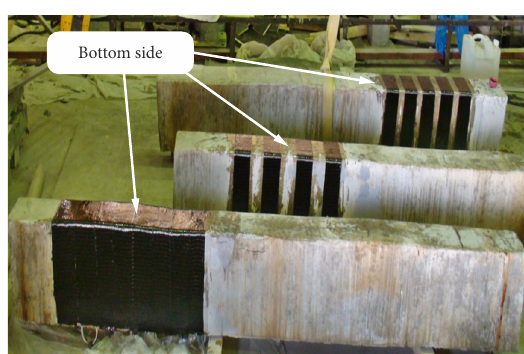
Figure 3. CFRP strengthened